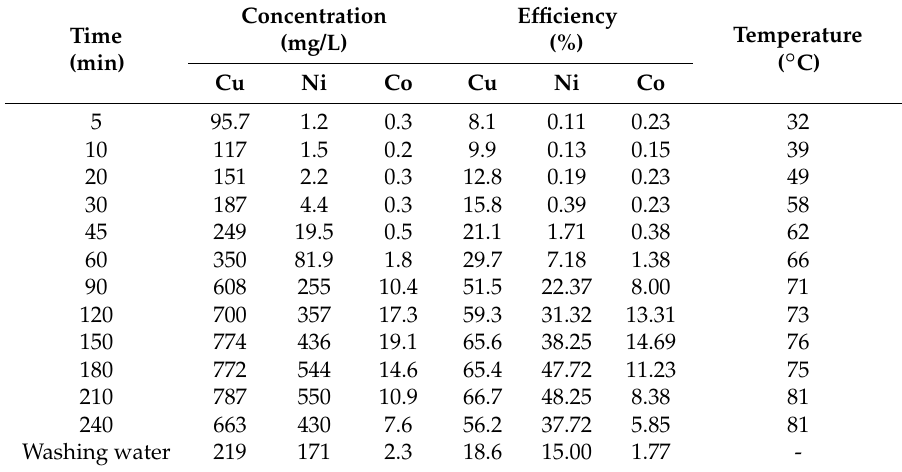
Table 9. Metals concentration and extraction efficiency of ammoniacal leaching with microwave (60 W). Concentration Time (mg/L) (min)